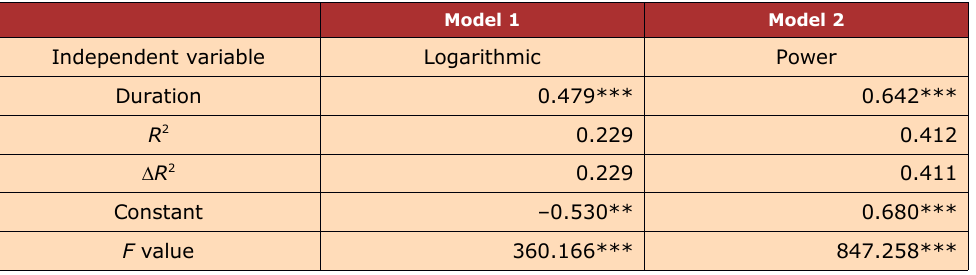
Table 6. Curve estimation of